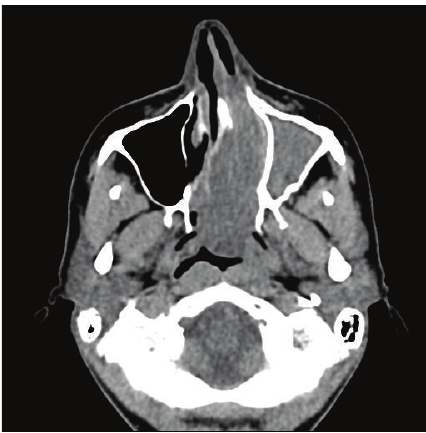
Figure 4: MRI (axial, T2 weighted) showing tumour involving the postnasal space, nasopharynx, and ethmoid air cells and secretions filling the left maxillary antrum and frontal sinus.